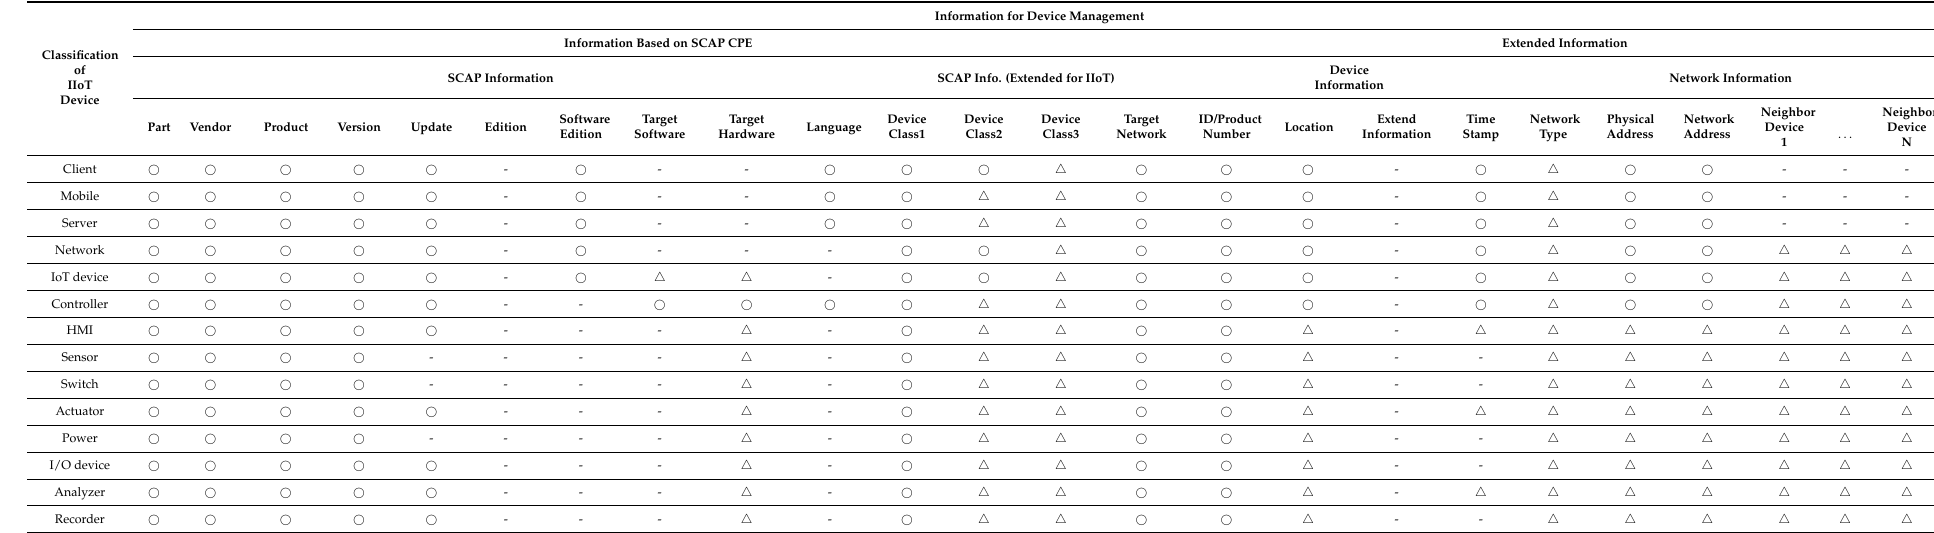
Table 1. Data structure for asset configuration